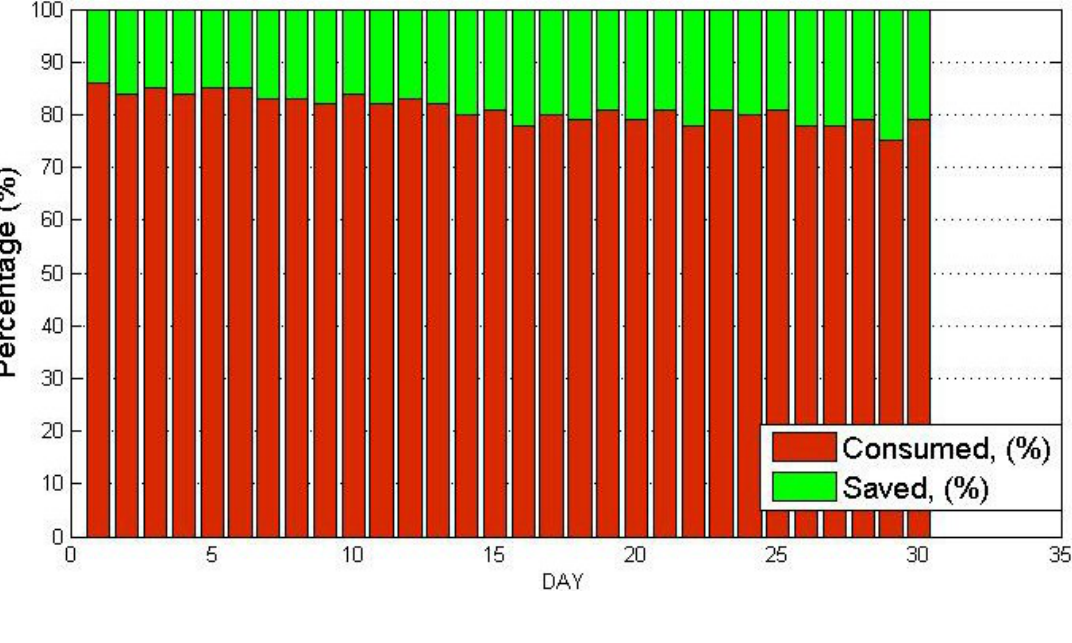
Figure 18. Percentage of energy saved in heating, considering user location